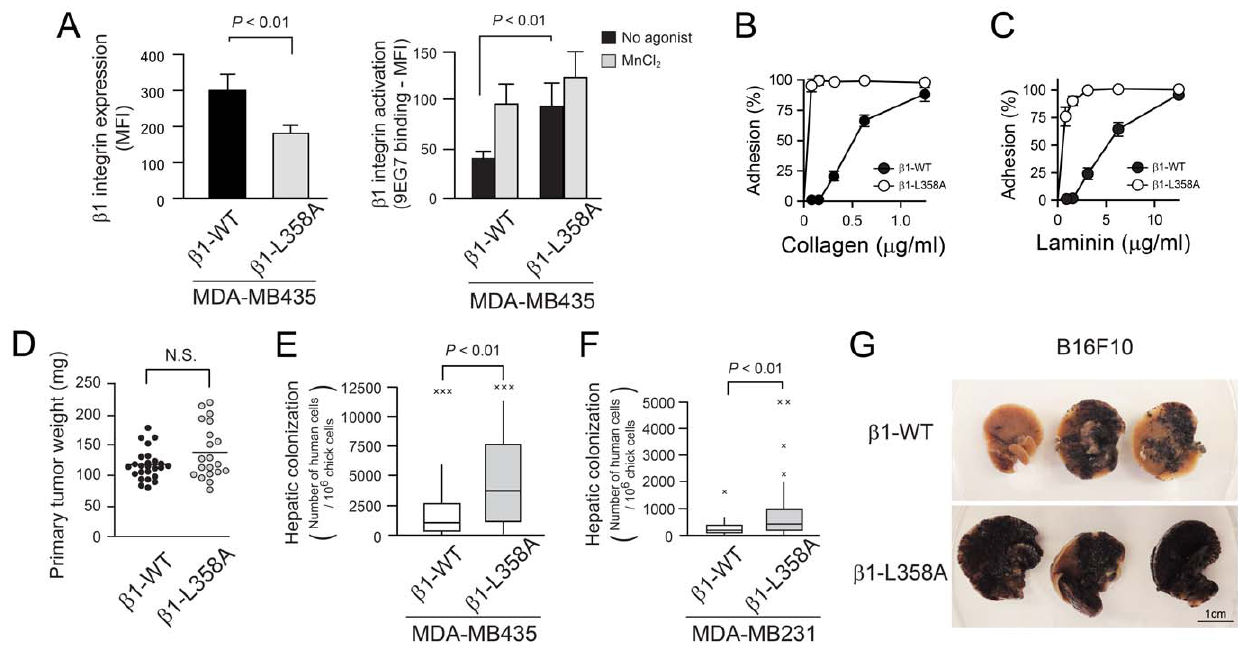
Figure 1. Activated b 1 integrins promote hepatic colonization by tumor cells in experimental metastasis assays. (A) b 1 integrin expression and activation determined by flow cytometry. Expression of b 1 integrins in MDA-MB435 melanoma cells was determined by binding of antibody TS2/16. Activation of b 1 integrins was determined by binding of antibody 9EG7 (basal: black bar, MnCl 2 stimulation: gray bar). Data represent mean fluorescence intensity in arbitrary fluorescence units (MFI) 6 SEM (n=8). (B and C) Tumor cell adhesion to collagen (B) and laminin (C). b 1 wild-type (WT) and b 1-L358A cells were incubated in 96 well plates coated with the indicated input concentrations of collagen or laminin for 60 minutes at 37 u C . Data are expressed as cell adhesion normalized to total input of cells. Data represent means 6 SEM (n=3). (D) Weight of primary tumors in the chick chorioallantoic membrane. 10 6 b 1-WT (n=25) or b 1-L358A MDA-MB435 cells (n=20) were resuspended in Matrigel and inoculated on top of the membrane of 10 day-old eggs. Tumor weight was measured after seven days of incubation. (E and F) Hepatic colonization in the chick embryo experimental metastasis assay. Box plots for tumor cell colonization in the chick embryo liver five days after intravenous injection. (E) MDA-MB435 melanoma cells ( b 1-WT: n=50 livers, b 1-L358A: n=32 livers) and (F) MDA-MB231 breast cancer cells ( b 1-WT: n=46 livers, b 1-L358A: n=51 livers). Human tumor cells in the chick embryo liver were quantified as described in Materials and Methods. (G) Representative images of hepatic melanoma metastases in a mouse experimental metastasis system seven days after intrasplenic injection of the indicated B16F10 mouse melanoma cells. Black, melanin-containing metastatic lesions were evident macroscopically.